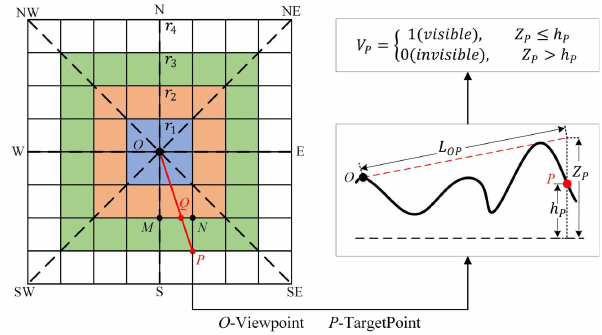
Figure 2. Principle of the Serial XDraw